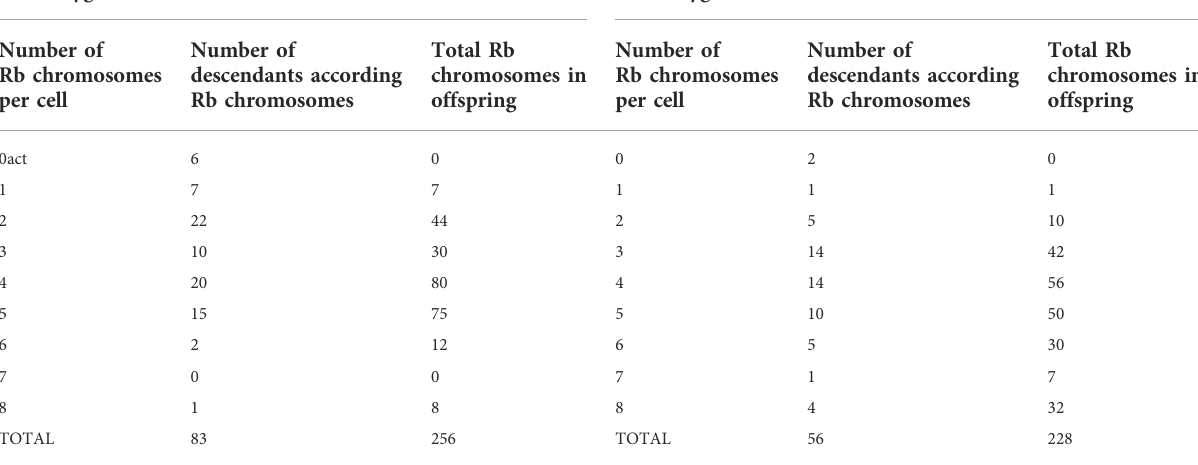
TABLE 2 Number of Rb chromosomes inherited by descendants of crosses between Rb heterozygous male or female parents and homozygotes 2n = 40, of Mus m domesticus mice. Heterozygous